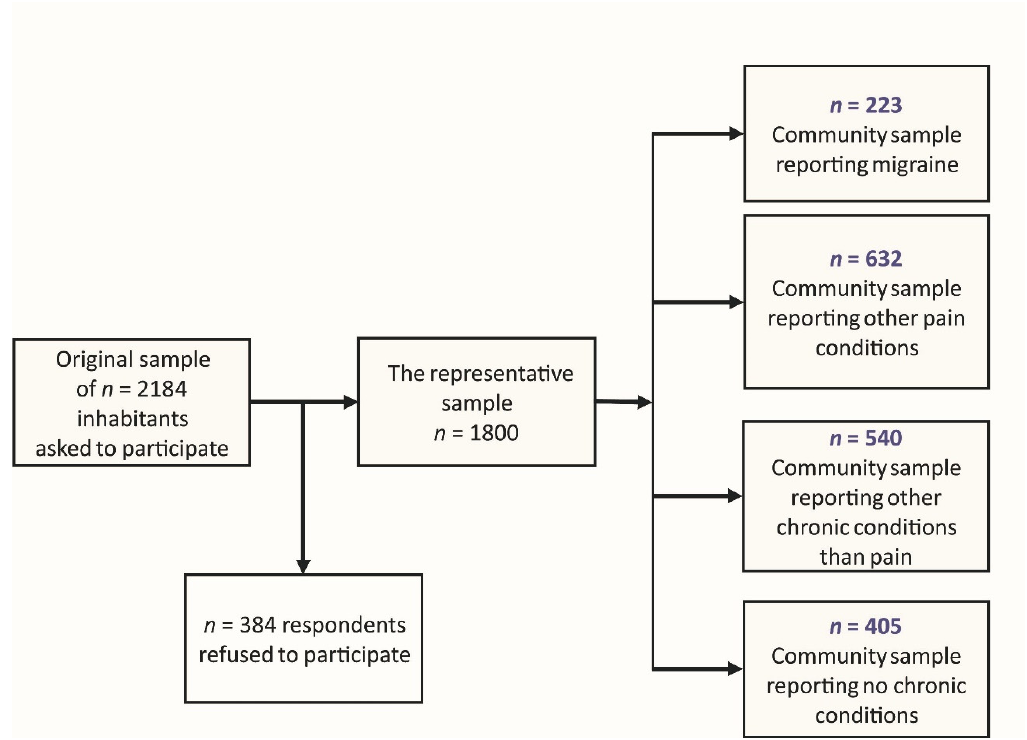
Figure 2. Scheme describing the final sample selection and research groups.